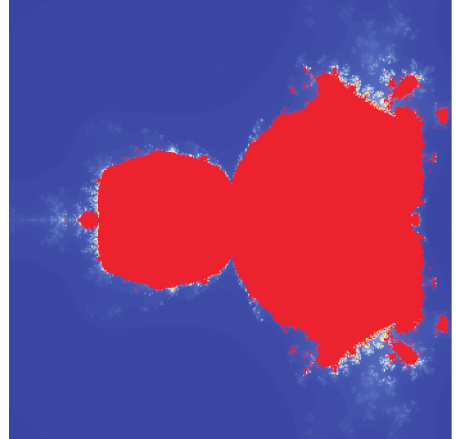
Figure 20: Cubic Mandelbrot set in JSOmhh.